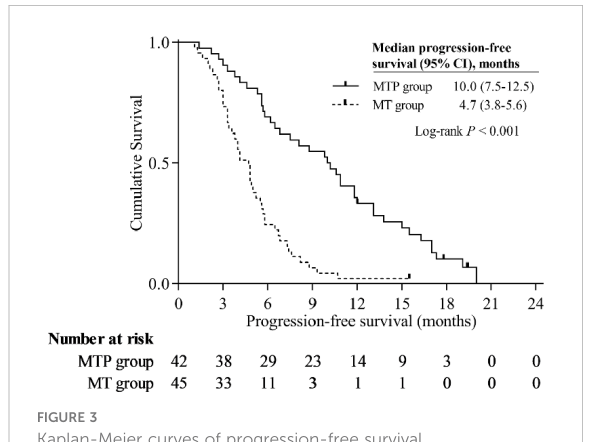
FIGURE 3 Kaplan-Meier curves of progression-free survival.